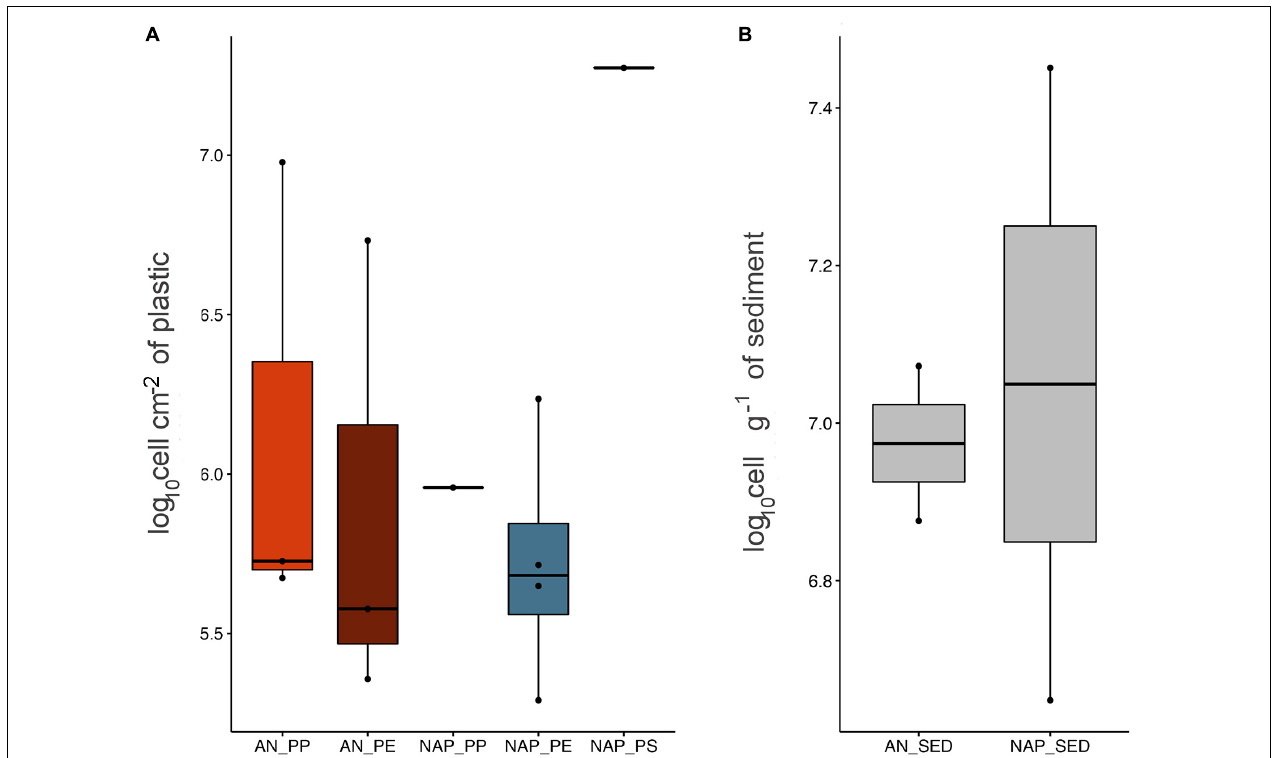
FIGURE 2 | Boxplot showing TPA on plastic items, expressed as cells by unit of surface (A) , and on sediment samples, expressed as cell per gram (B) . Boxplots were calculated considering an average value derived from triplicate determinations carried out for each